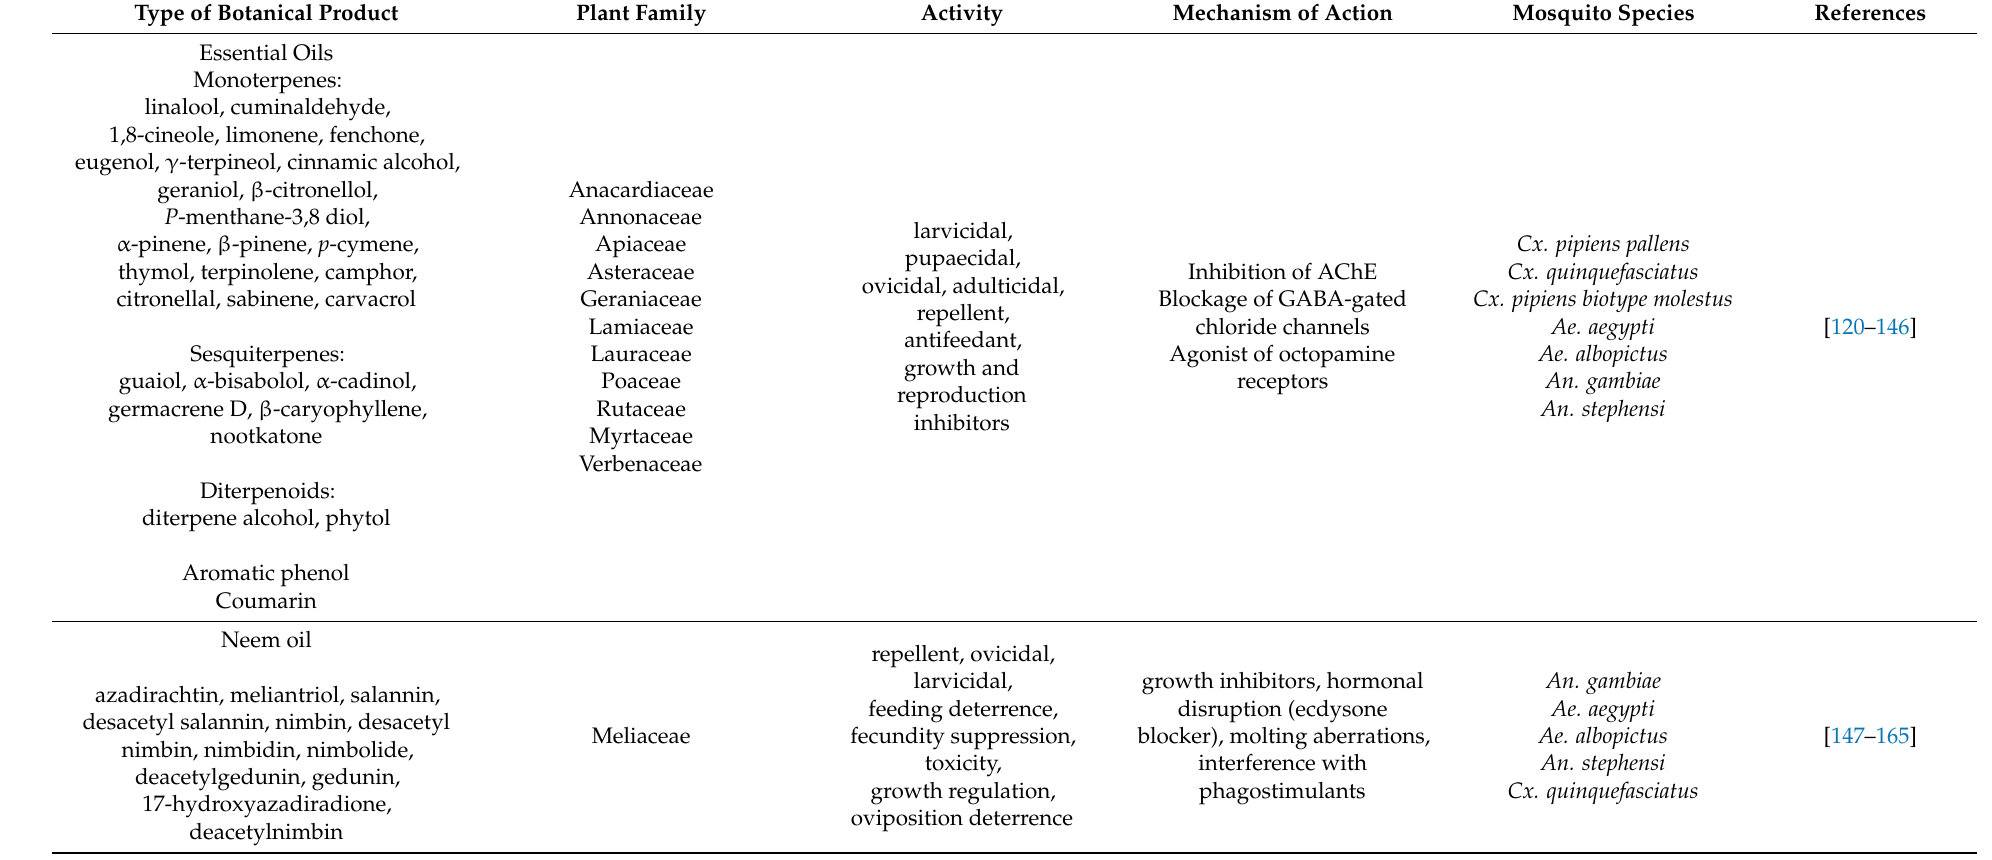
Table 1. An overview of insecticidal activity and mechanism of action of various plant-based compounds against mosquito